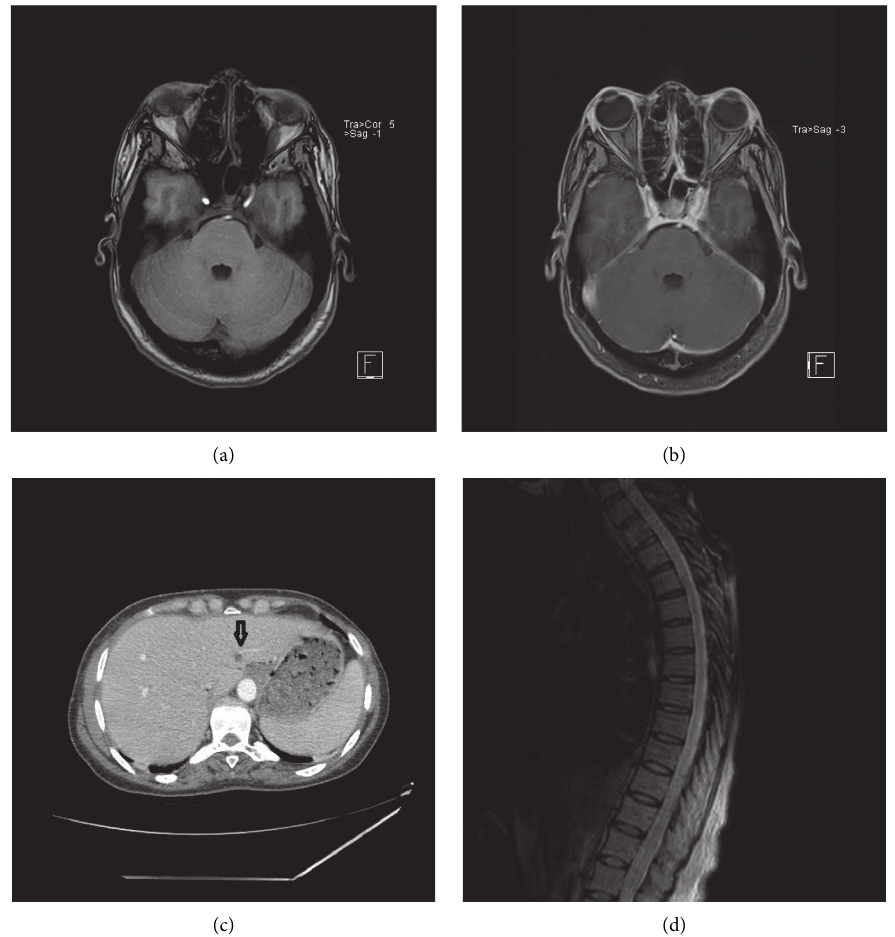
Figure 1: (a) MRI brain precontrast. (b) MRI brain postcontrast, showing dural enhancement. (c) CTchest, abdomen, and pelvis showing the hypoattenuating nodule in the liver (arrow). (d) MRI lower thoracic spine showing mild degenerative